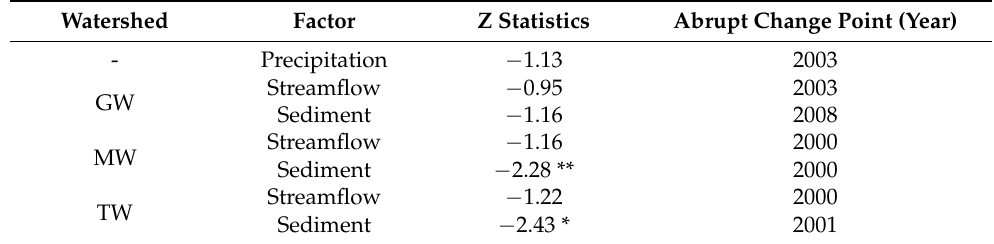
Table 1. The MK trend test results of the annual precipitation, streamflow, and sediment.